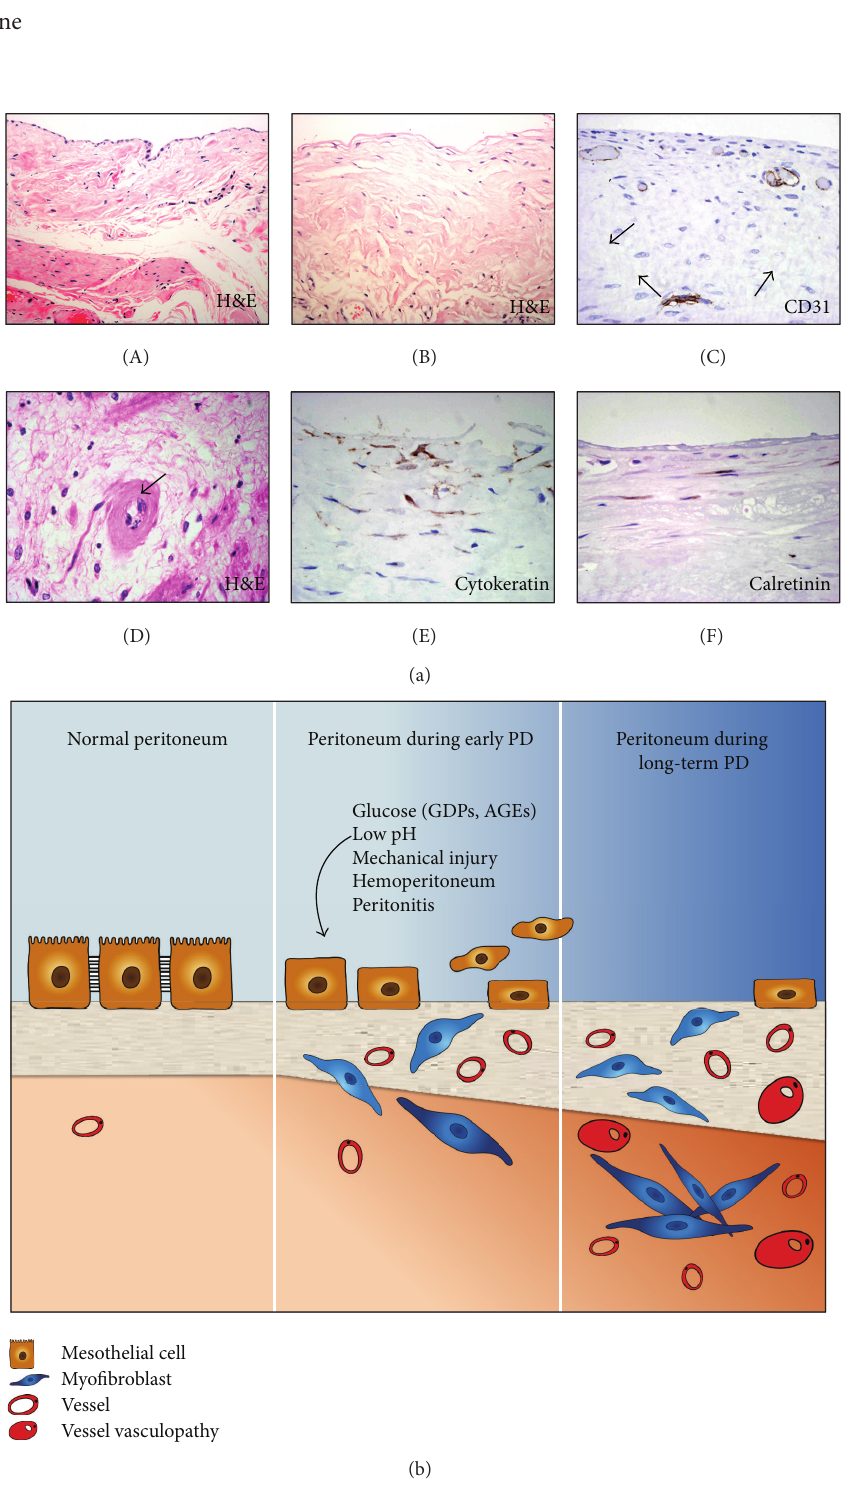
Figure 1: Structural alteration of the peritoneal membrane during PD. (a) Normal peritoneal tissue from a healthy donor stained with Haematoxylin-eosin (H&E) shows a preserved MCs monolayer that lines a compact zone of connective tissue (A). Peritoneal membrane from a PD patient stained with H&E shows the loss of the MCs monolayer and increased thickness of the compact zone (B). Magnification × 200. Staining of the peritoneal vessels with anti-CD31 antibody demonstrates an intense angiogenesis in peritoneal membrane from PD patient (C). Hyalinizing vasculopathy can be observed in the peritoneal tissue from PD patient (D). Immunohistochemical analysis of the peritoneal membrane from PD patient reveals the presence of fibroblast-like cells embedded in the fibrotic stroma expressing the mesothelial markers cytokeratins and calretinin (E) and (F). Magnification × 150. (b) Schematic representation of the progressive alterations of the peritoneal membrane in the time course of